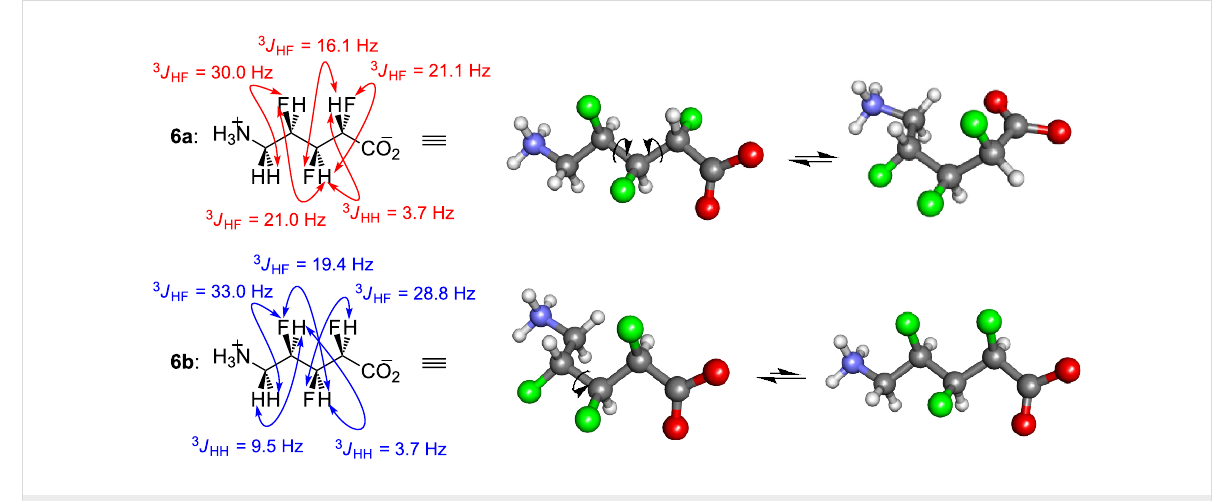
Figure 2: Selected J values and the inferred molecular conformations of 6a and 6b .